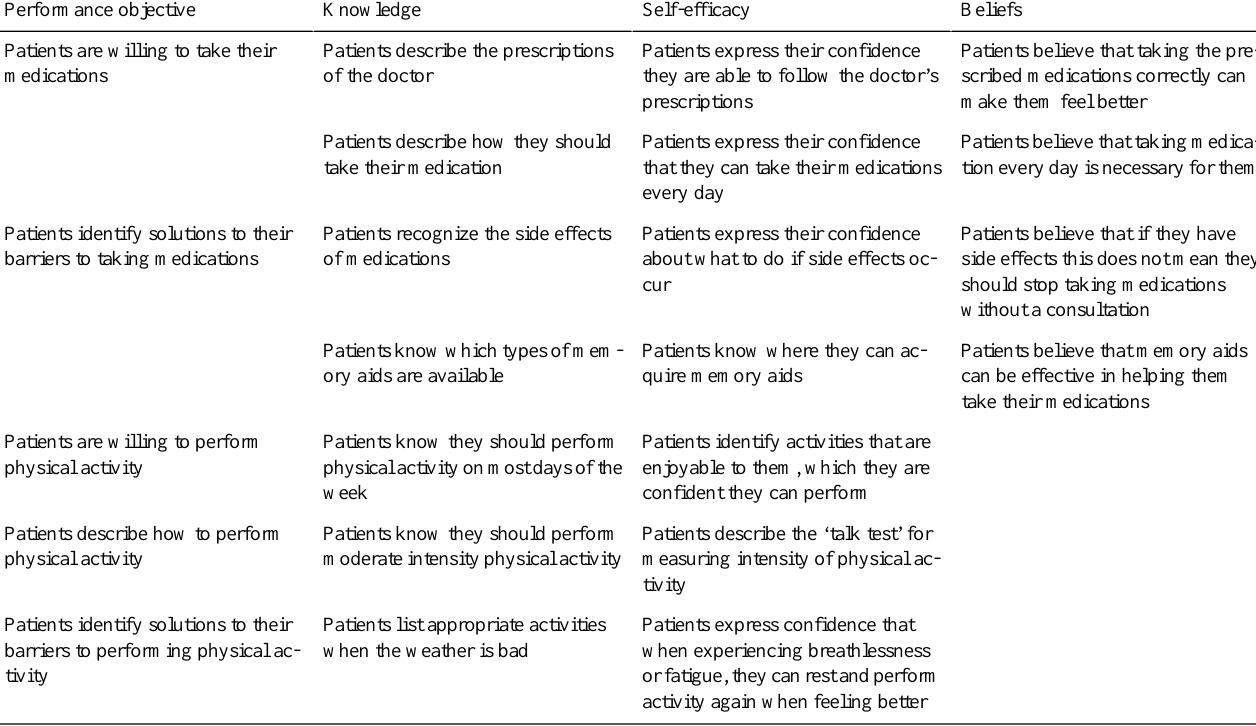
Table 2. A selection of matrices of change objectives for the five performance objectives. BeliefsSelf-efficacyKnowledgePerformance